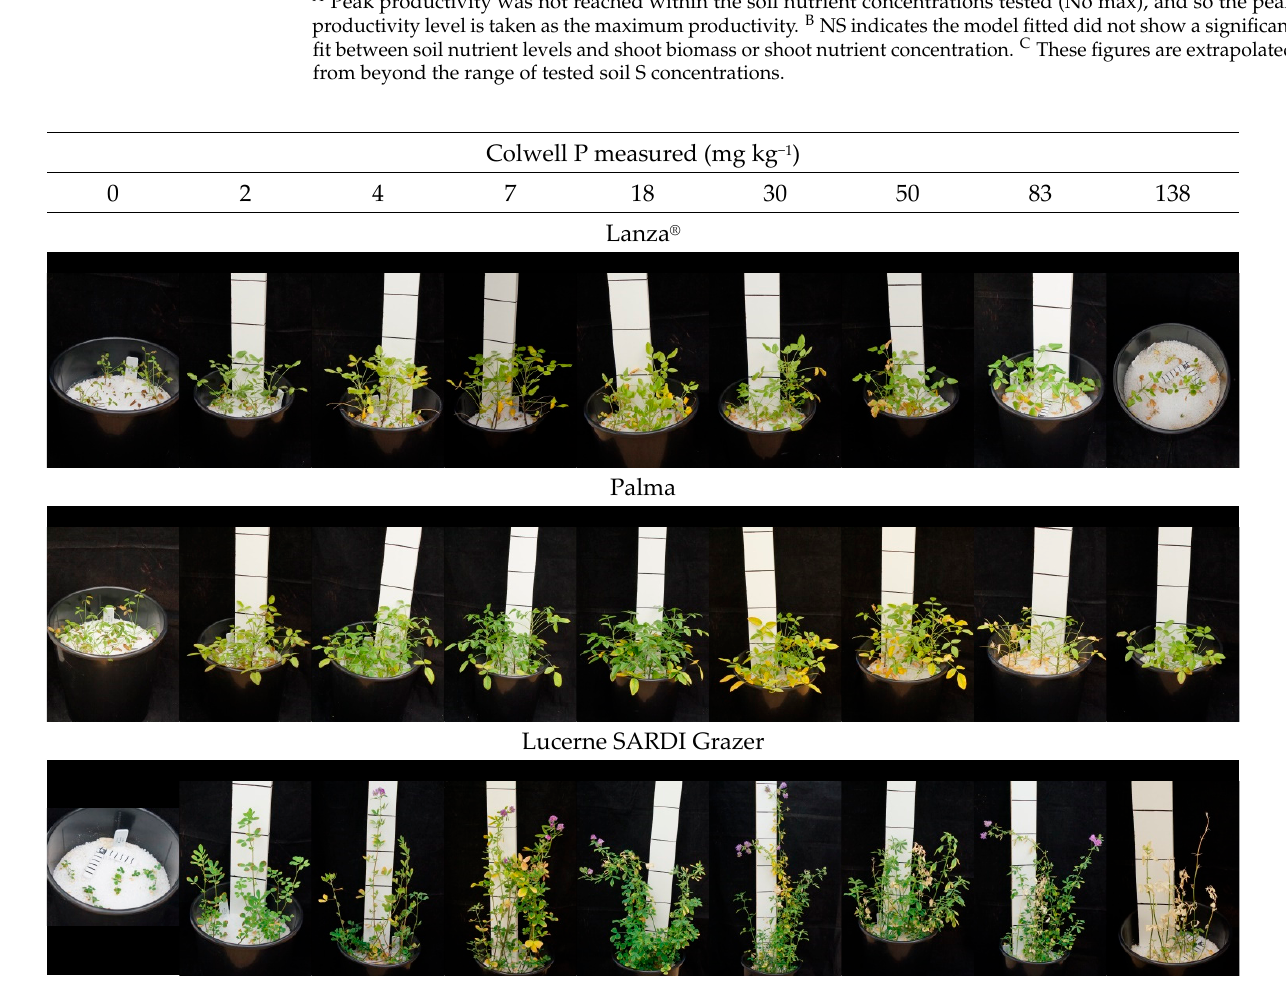
Figure 3. Images of pots containing 12-week-old Lanza ® (top), Palma (middle), and lucerne (bottom) grown in the glasshouse with differing levels of soil Colwell P. Black lines on large scale bars are 10 cm intervals.